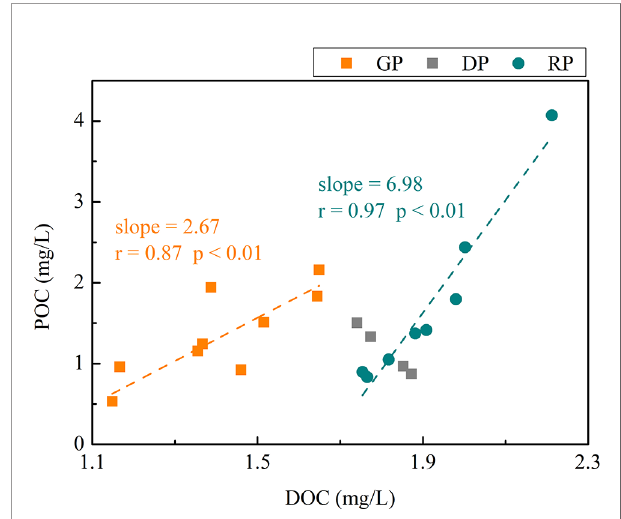
FIGURE 2 | The relationship between the ratio of DSi and DIN consumption rate and DSi/DIN ratio. The points in red circle were the ratios of four group at the day 3.